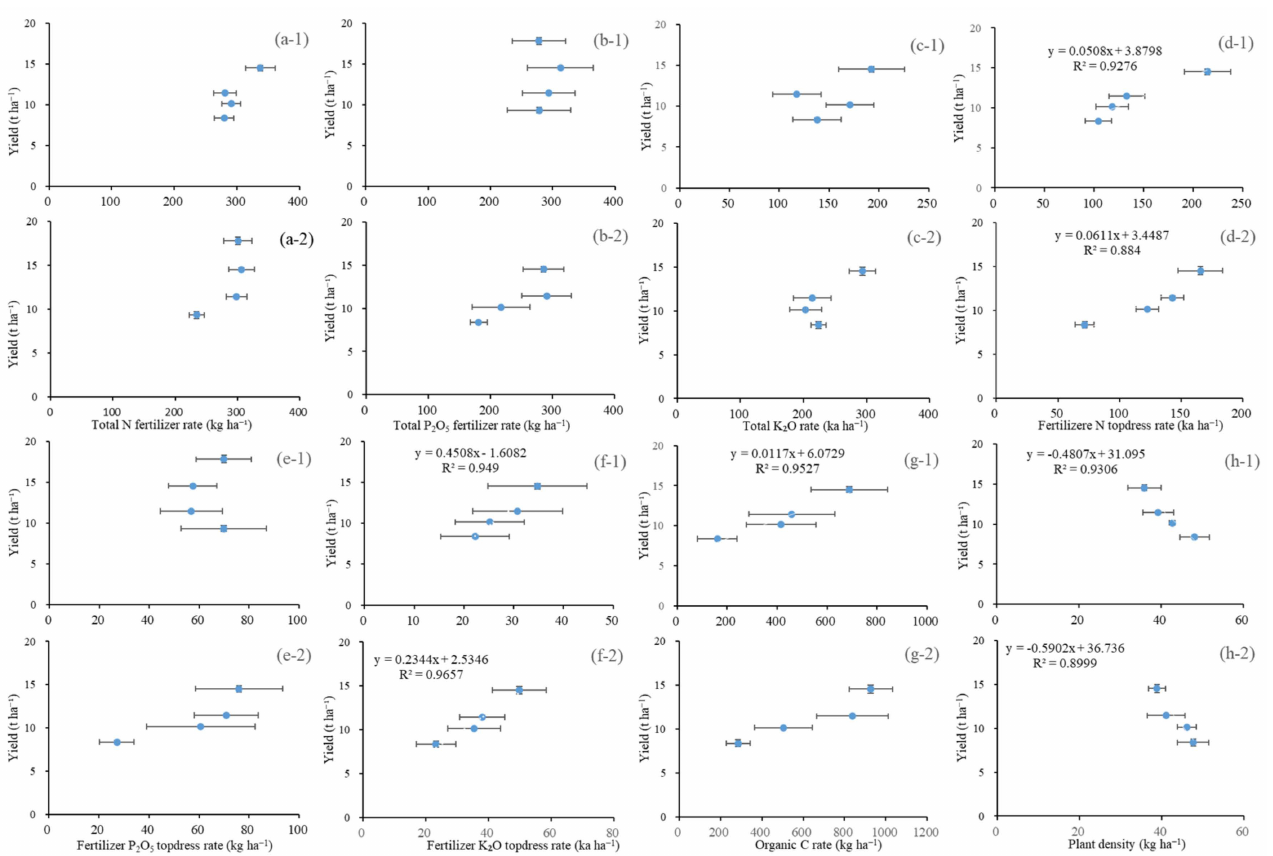
Table S4: The application rate and price of various agricultural inputs for farm management under different elevation level for cabbage production. HAL represents high elevation level (900–1200 m), LAL represents low elevation level (500–800 m). The marketing price were obtained from the dealer in CNY, and converted into USD based on an average exchange rate of 7. References [50–61] are cited in the supplementary